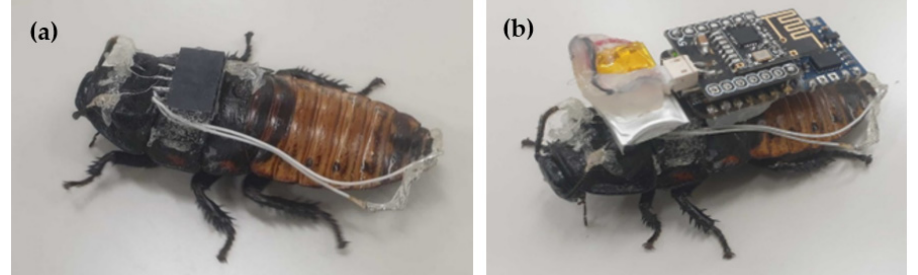
Figure 3. MHC as the biobot: ( a ) implanted electrode on antenna and cerci; ( b ) biobot with the proposed electronic backpack.